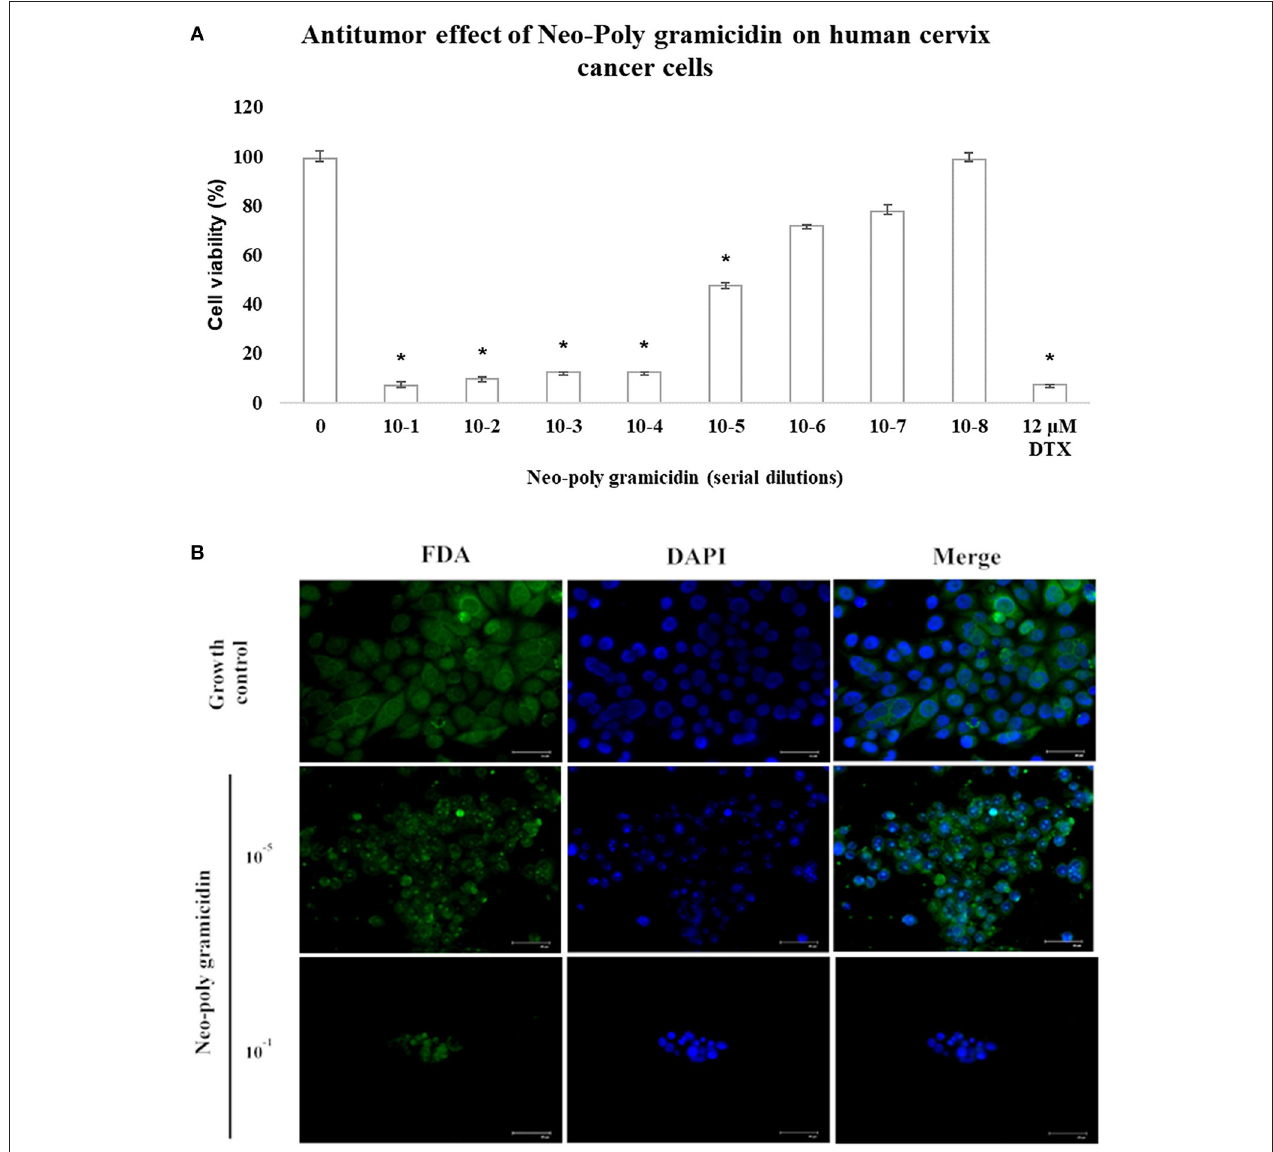
FIGURE 2 | Antitumor effect of Neo-Poly gramicidin on HeLa cell line. (A) Cell viability ( via MTT assay) after a 24-h exposure to serial dilutions of Neo-Poly gramicidin (10 − 1 to 10 − 8 ) and 12 µ M docetaxel (DTX; positive control of cytotoxicity). Readings were performed in triplicate. Results are representative of three independent experiments. The antitumor effect of Neo-Poly gramicidin was dose dependent and significant as of dilution 1:10 5 ( p < 0.0001). Asterisks indicate statistical differences ( α = 0.05). (B) Cell morphology after a 24-h exposure to dilutions of Neo-Poly gramicidin (10 − 1 and 10 − 5 ). Untreated cells served as a growth control. nuclei are stained blue with 4,6-diamidino-2-phenylindole (DAPI). FDA, fluorescein diacetate (green). Bar = 125 µ m.